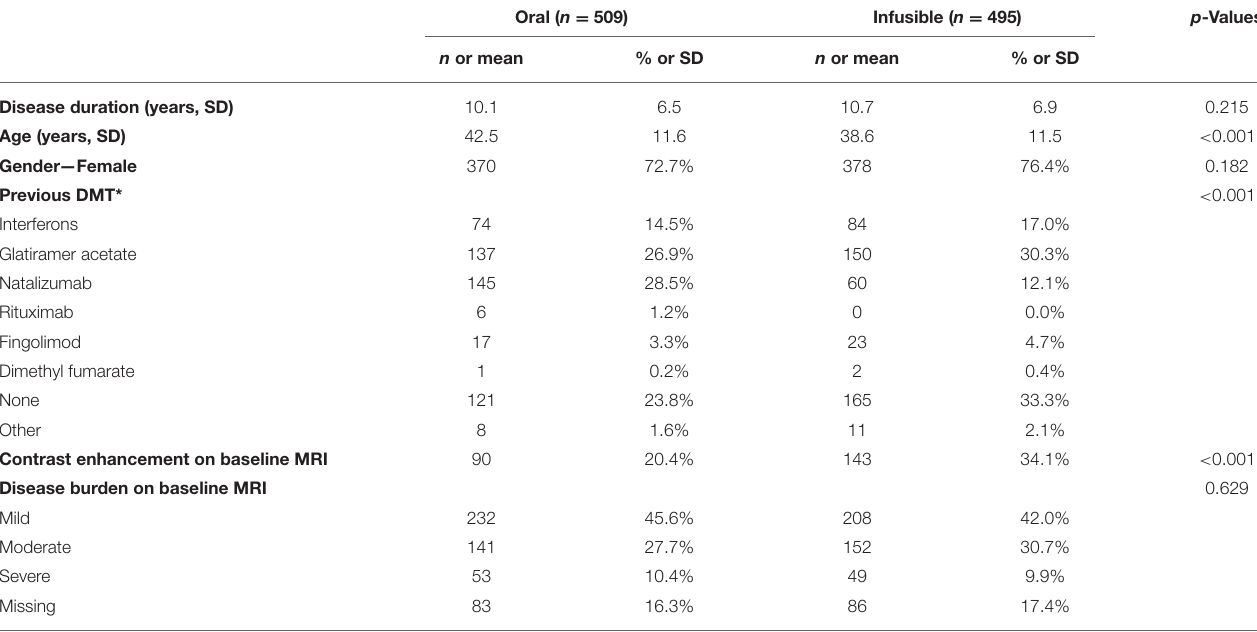
TABLE 1 | Baseline characteristics for oral vs. infusible in patients with relapsing forms of MS. Oral ( n = 509) Infusible ( n = 495) p -Values n or mean % or SD n or mean % or